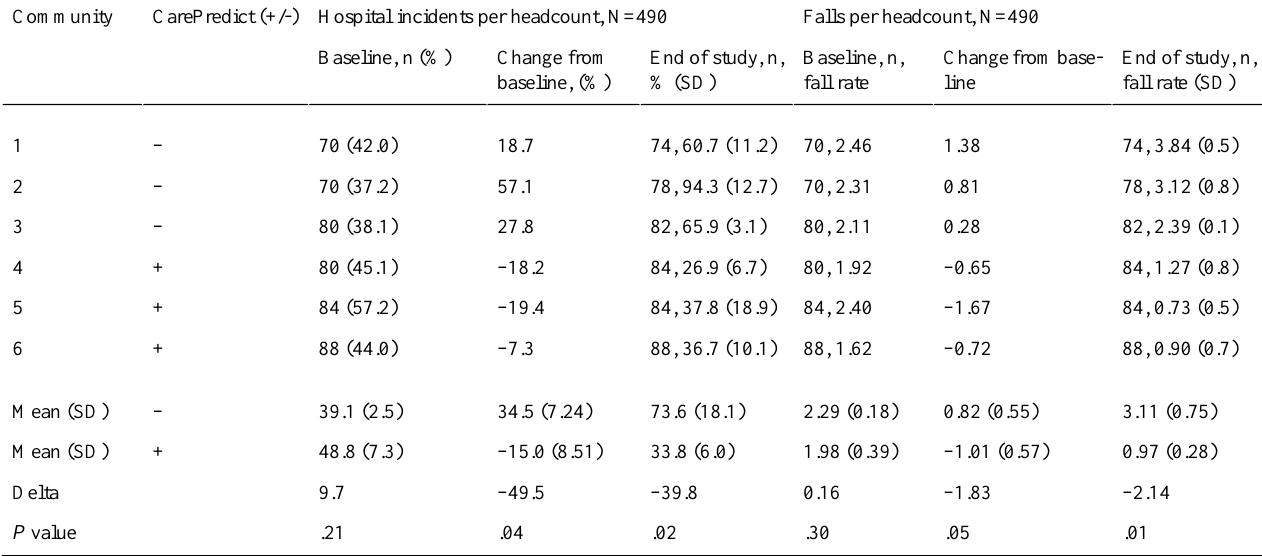
Table 3. Outcomes: hospitalization and fall rates for six assisted living